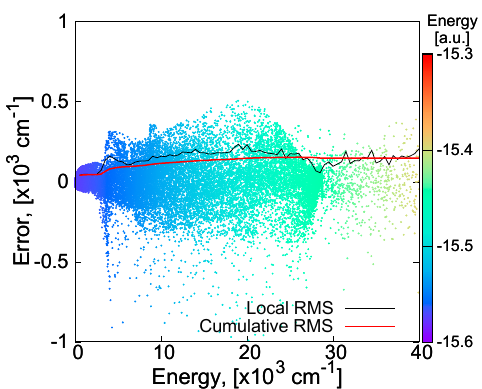
Figure 4. Fitting error distribution of the global analytical PES of Li 2 H in the energy domain (in cm − 1 ).